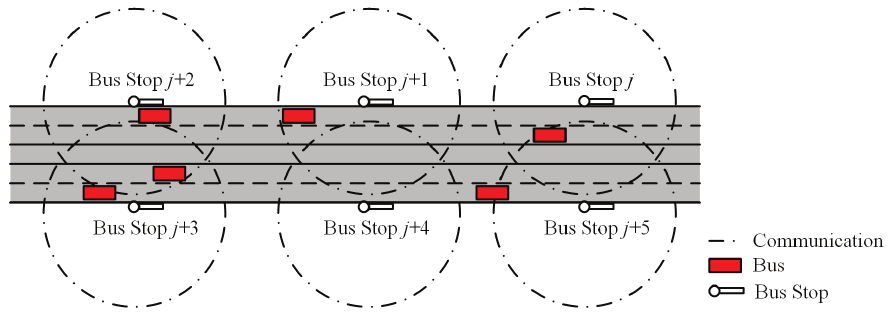
Figure 3. A typical scenario of the bus system. Note that j is the bus stop